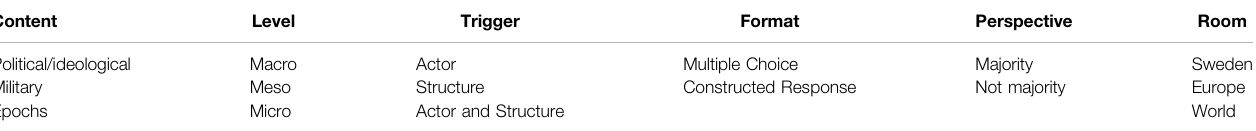
TABLE 2 | Model to categorize the items.